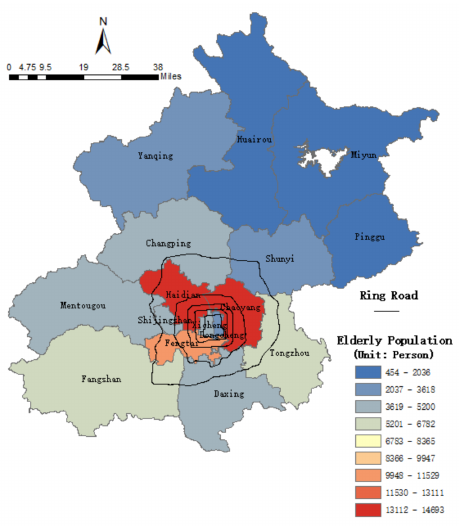
Figure 5. Home location detection distribution of the elderly cardholders.